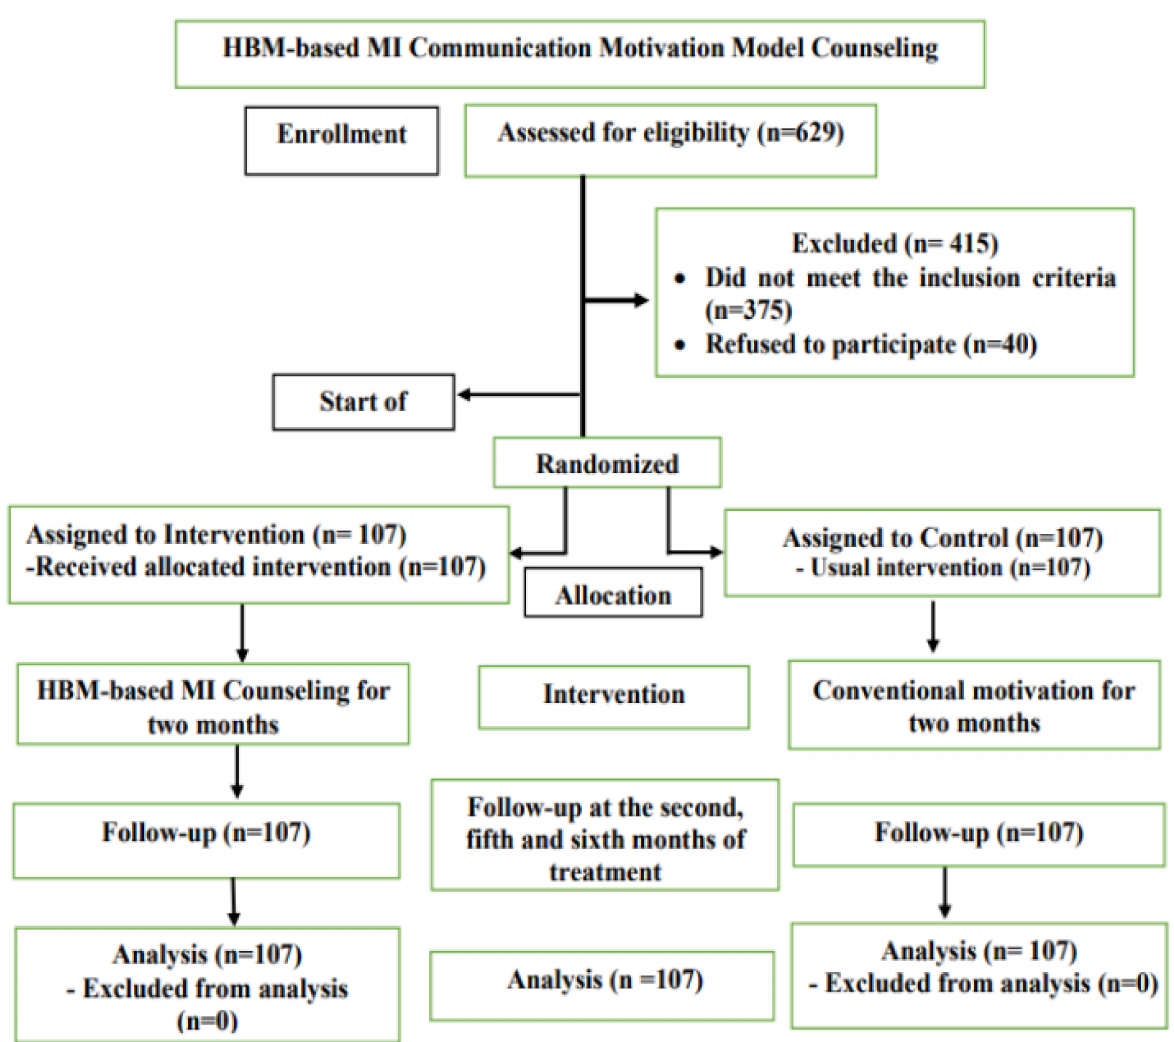
Figure 1. Consolidated Standards of Reporting Trials (CONSORT)